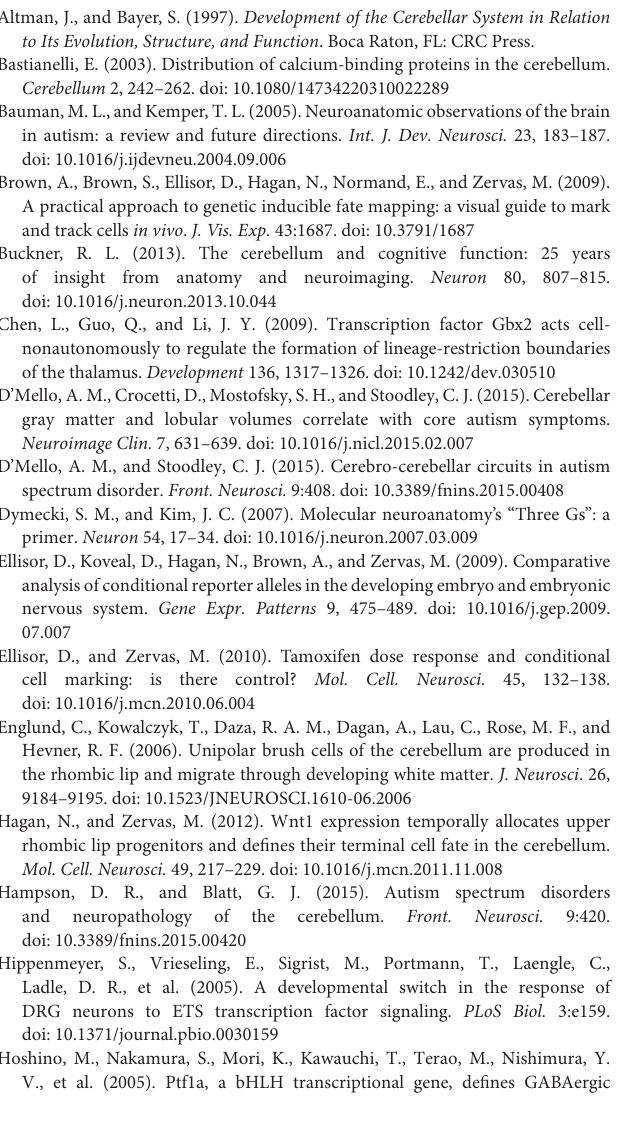
constitutively and heritably marked with high reproducibility. (E) In summary, the absence of tamoxifen, even in the presence of CreER and the reporter yields cells that are not marked. (F) However, the presence of CreER (driven by Gbx2 ) plus tamoxifen causes neurons to be marked with nuclear LacZ and mGFP. Supplemental Figure 2 | Summary schematic of the Gbx2 lineage contribution to granule cells. The cerebellar primordium is located within the roster Hb (r1) and at E8.5 is partitioned into anterior r1 (rostral, indicated by the light green box) and posterior r1 (caudal, indicated by the light blue box). These domains are transposed 90 degrees to become the medial vermis and lateral hemispheres, respectively, of the adult Cb (based on Sgaier et al., 2005). A more nuanced description is that rostral-medial (RM) domains become posterior vermis (VP) while rostral-lateral (RL) domains become anterior vermis (VA). In contrast, the caudal-medial (CM) domains become posterior-hemisphere (HP) tissue and the caudal-lateral (CL) domains become anterior-hemisphere (HA) tissue. The density of stippling indicates the relative contribution to granule cells. The Gbx2 lineage was marked at early (E7.5 and E8.5, orange), intermediate (E9.5, light blue), and